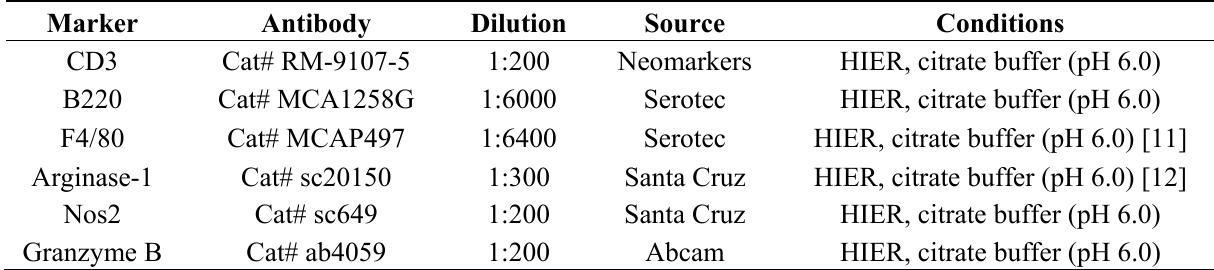
Table 3. Primary antibodies and their commercially available sources, catalog numbers, dilutions and specific antigen retrieval conditions utilized in the